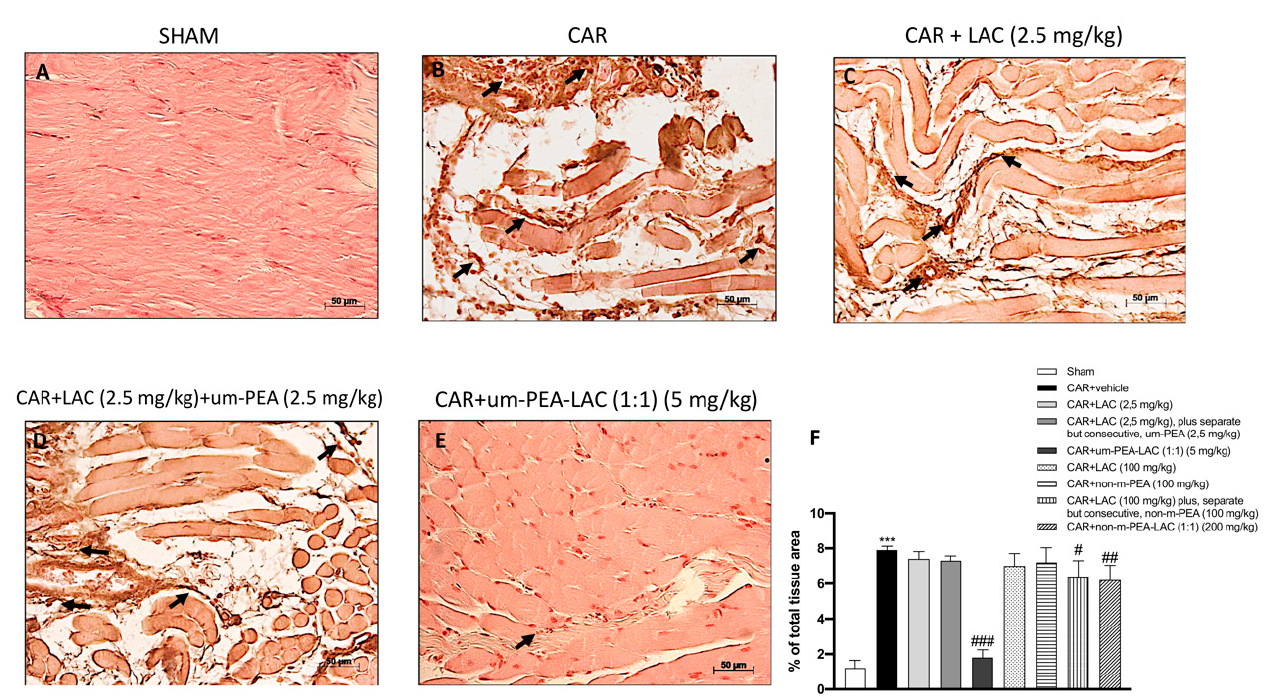
Figure 8. Efficacy of um-PEA and LAC treatment on iNOS expression. Tissues obtained from CAR injected-animals exhibited positive immunostaining for iNOS ( B , F ), compared to the sham-treated animals ( A , F ). Um-PEA and LAC (5 mg/kg) treatment reduced this expression ( E , F ); this reduction was milder with CAR + LAC (100 mg/kg) plus, separate but consecutive, non-m-PEA (100 mg/kg) and CAR + non-m-PEA and LAC (1:1) (200 mg/kg) (data not shown). Other treatments did not display a significant decrease in iNOS expression ( C , D , F, and data not shown). Black arrows indicate the positive staining for iNOS. Data are representative of at least three independent experiments. Values are means ± SEM. One-Way ANOVA test. *** p < 0.001 vs. sham; # p < 0.05 vs. CAR; ## p < 0.01 vs. CAR; ### p < 0.001 vs. CAR.